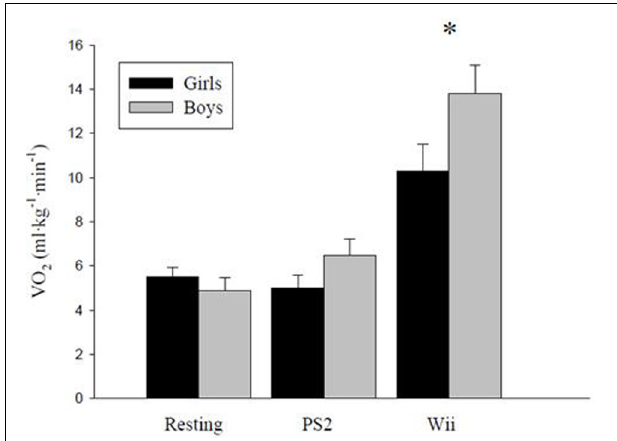
FIGURE 2 | VO 2 for gaming condition by sex: mean ± s.e.m. for gaming condition by sex. There was a significant increase ( p = 0 . 02) in VO 2 from the resting condition to “exergame” (Wii™) in boys but not girls. PS2, Playstation 2™ (sedentary game).